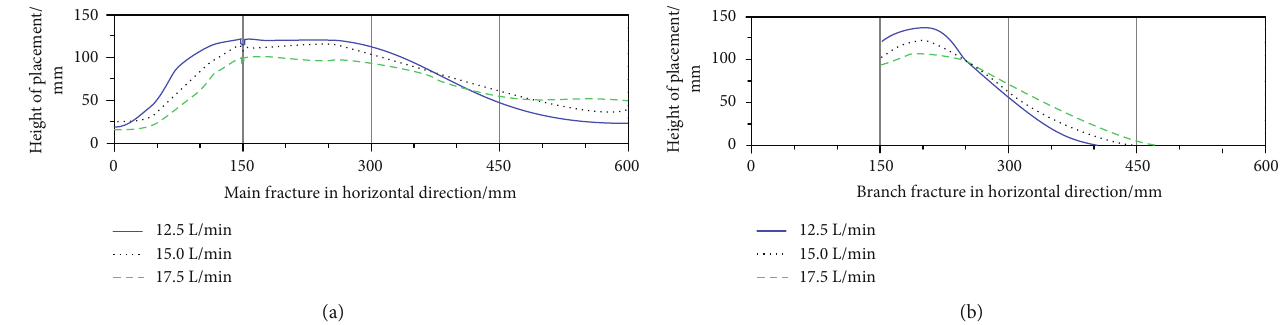
Figure 11: The transport characteristics of proppants in the main fracture (a) and branch fractures (b) with di ff erent displacements.